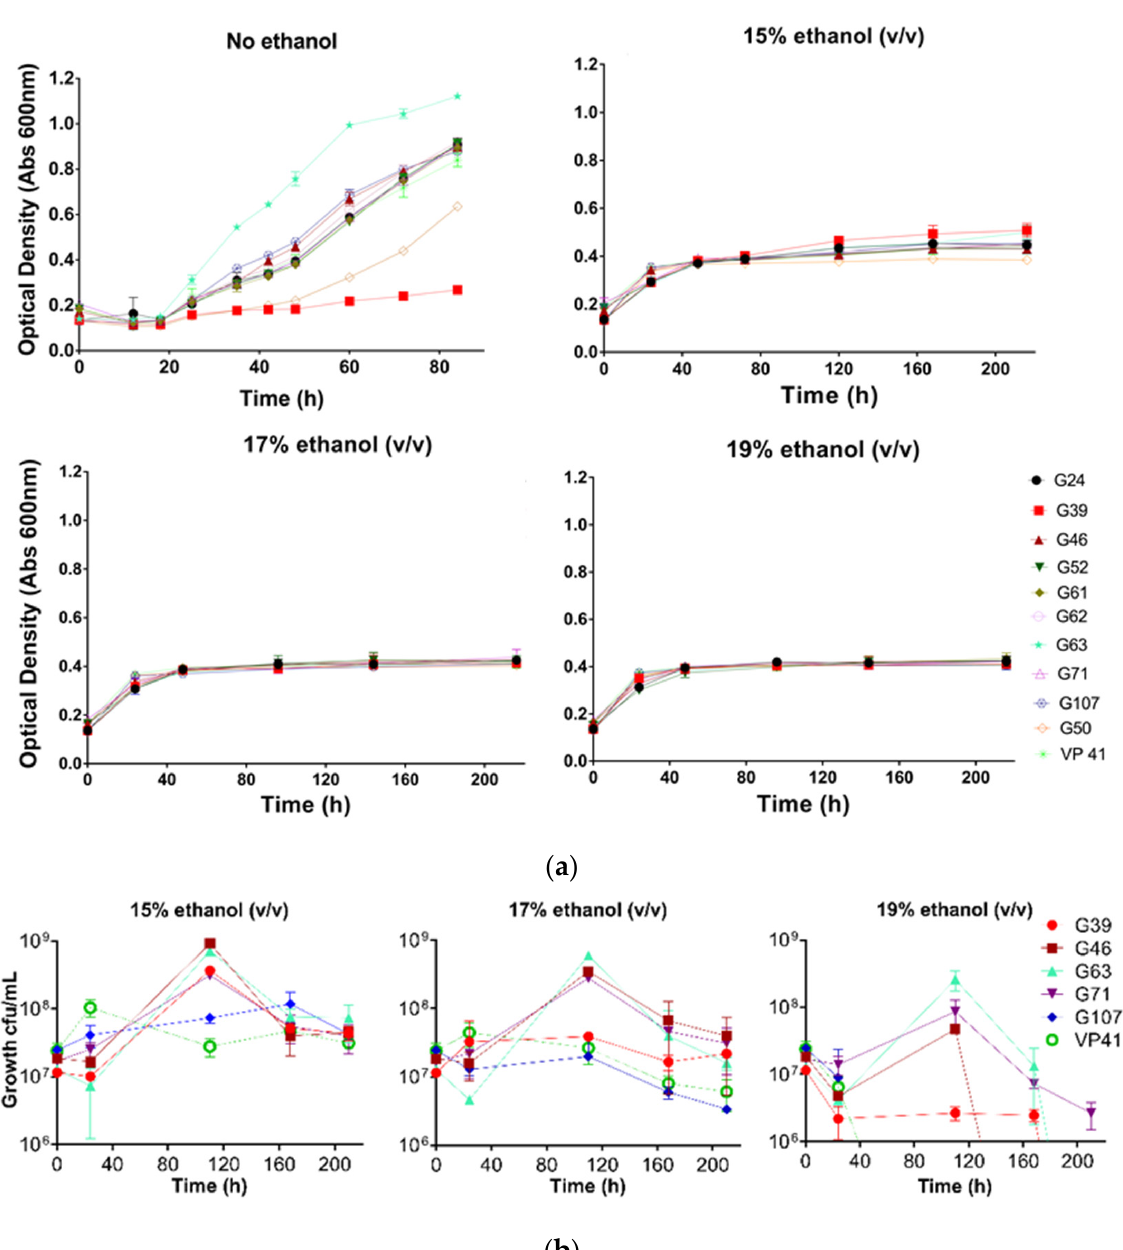
Figure 2. Growth of O. oeni isolates in MRS-AJ that contained 15%, 17%, and 19% ( v / v ) ethanol, respectively, determined by ( a ) Abs 600 ; ( b ) drop plate counting (bars represent one standard deviation ( n = 3)).